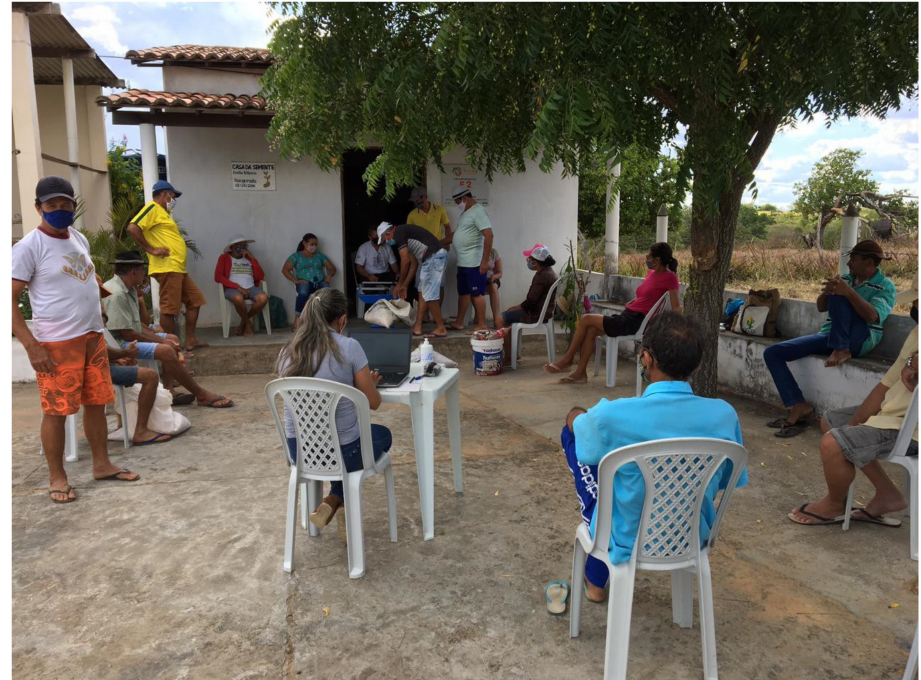
Figure 12. Capacity building meeting at a Community Seed Bank. Photo credit: Semi-arid Agrobiodi- versity Management Program and Agrobiodiversity of the Semi-arid Project image bank. F á tima, Bahia, Brazil, February